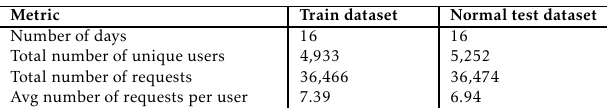
Table 2. Summary of the normal experimental dataset.